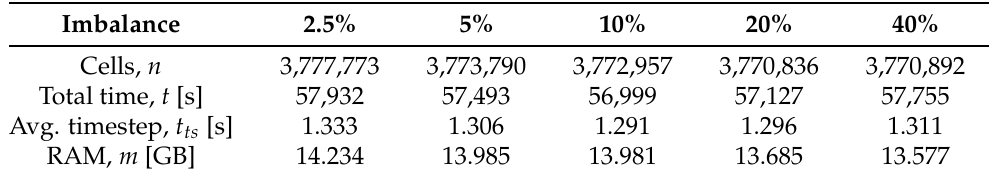
Table A14. Influence of the load balancing (imbalance adjustment) on the computational time. Setup is identical to Table A7 with refinement frequency set to 1000